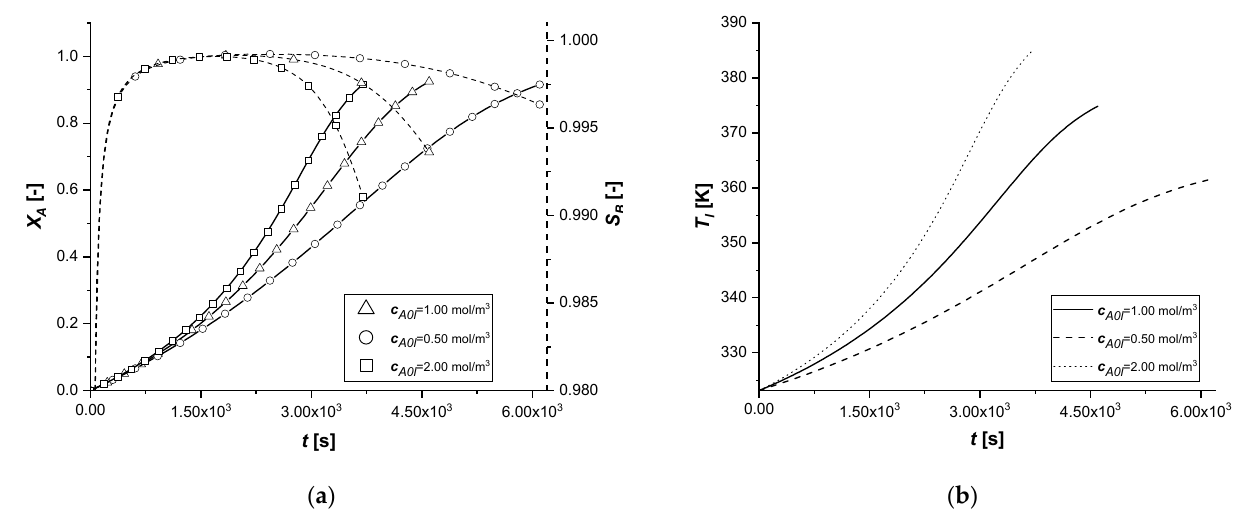
Figure 26. ES c A 0,l investigation. ( a ) Bulk profiles over time of X A and S B . ( b ) Bulk profile of T l over time.